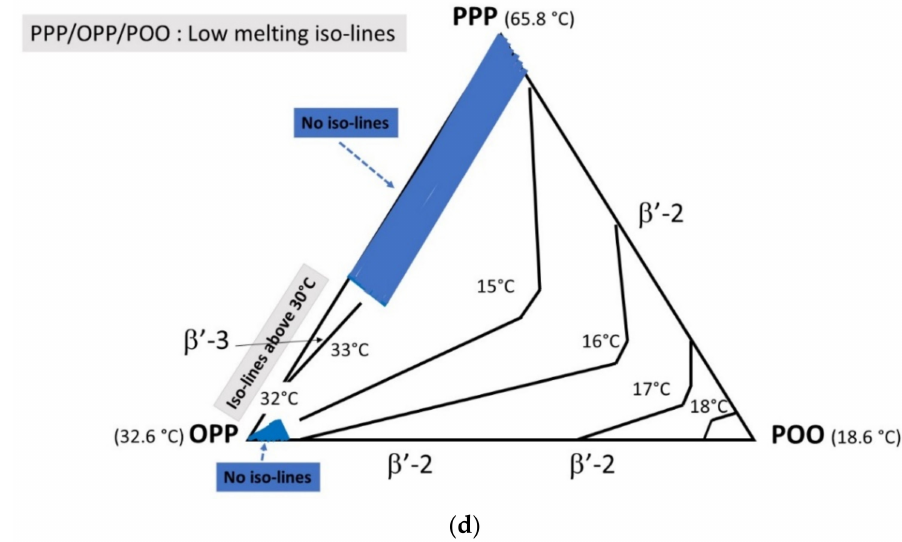
Figure 7. ( a ) (PPP / POP / POO) phase diagram high melting iso-lines; ( b ) (PPP / POP / POO) phase diagram low melting iso-lines; ( c ) (PPP / OPP / POO) phase diagram high melting iso-lines and ( d ) (PPP / OPP / POO) phase diagram low melting iso-lines, in tempered